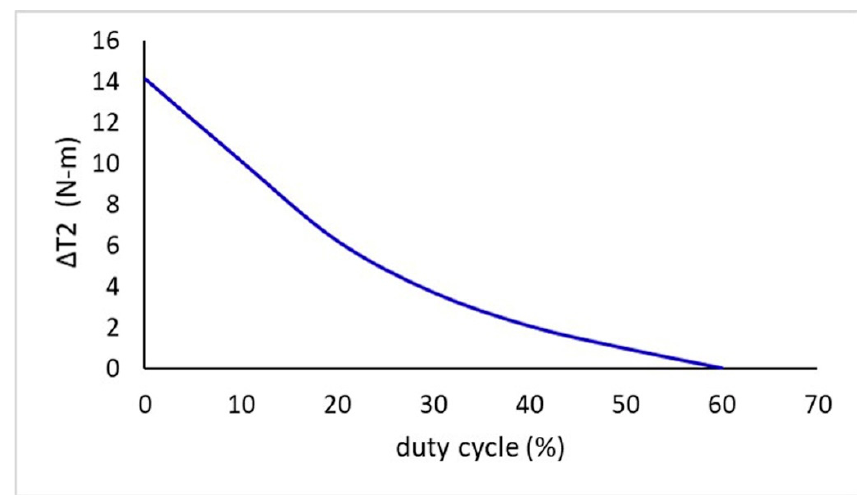
Figure 9. Drop in torque with duty cycle at 5 kHz frequency.